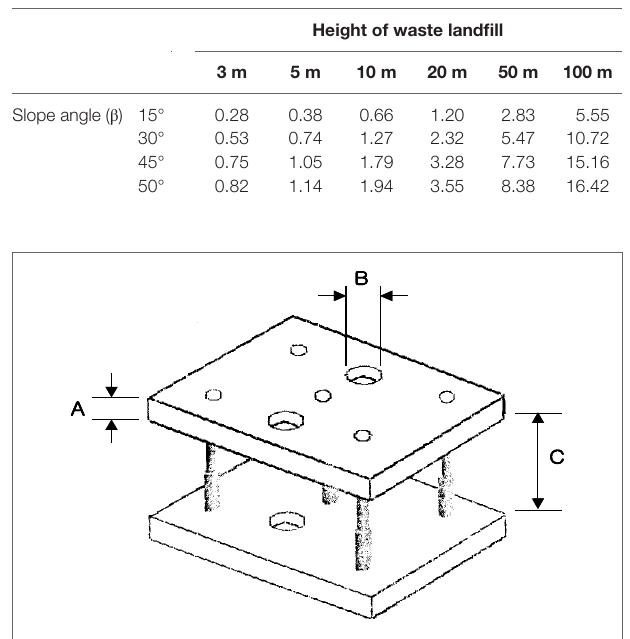
TaBle 3 | Tensile strength (kg/cm 2 ) of separation box plate as a function of the slope angle ( β ) and height of the waste landfill.